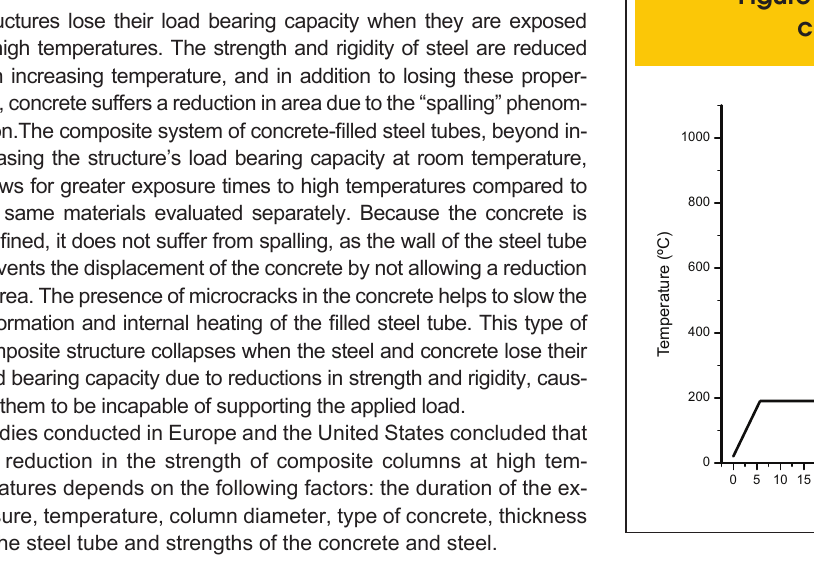
Figure 1 – Temperature elevation curve with pre-heating